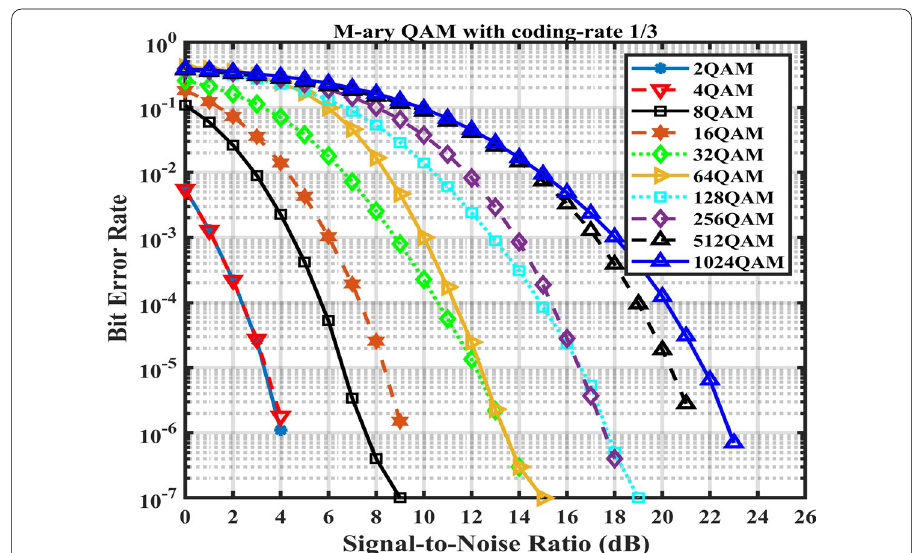
Fig. 11 BER versus SNR for different M-ary QAM with 1/3 code rate. This graph depicts the performance of different M-ary QAM with 1/3 code rate combination. The performance is described in terms of BER versus